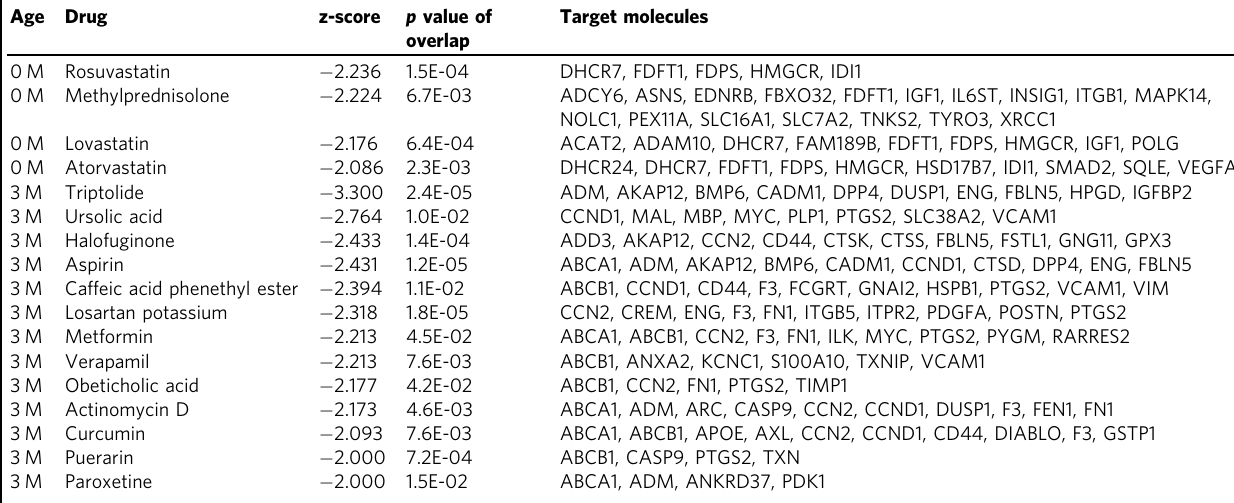
Table 1 Drugs from upstream analysis that are predicted to normalize gene expression modulation at 0 and 3 M.